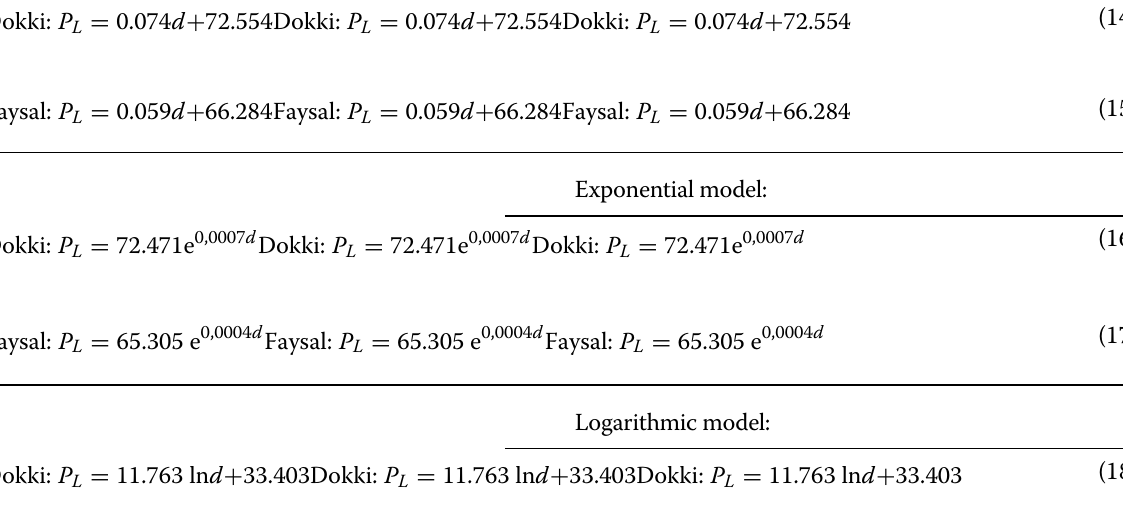
n 8.546. The detailed comparisons of the linear, expo- = nential and logarithmic regression characteristic for Dokki and Faysal territories are shown in Figs. 10 and 11, respectively.